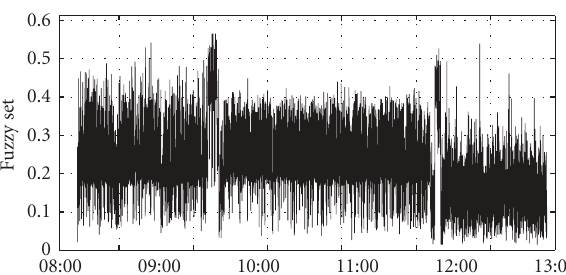
Figure 12: Fuzzy set F for a typical dynamic position condition.